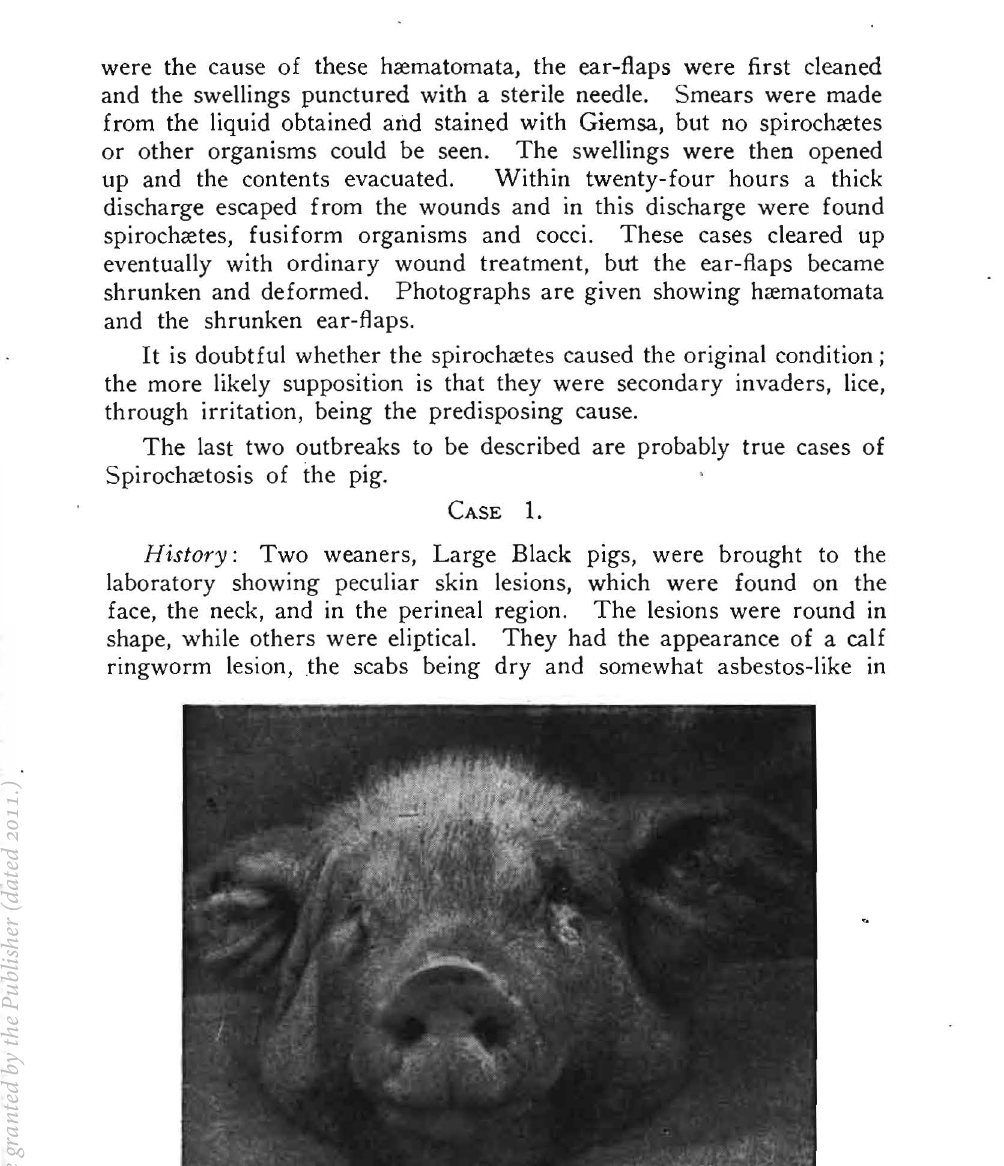
Fig. 1. - Head of pig showing shrunken right ear-flap as a result of opening hamtalomata of ear.